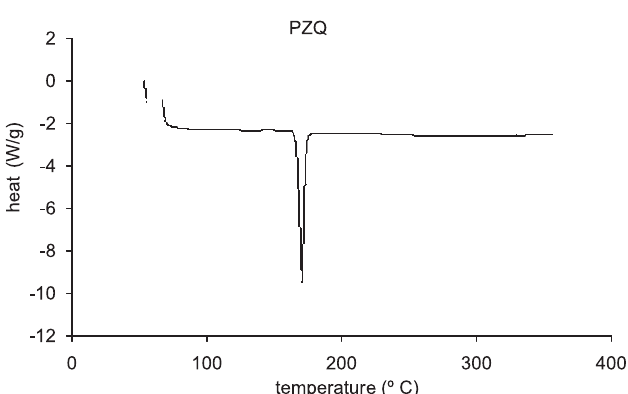
FIGURE 1 - Representative DSC of